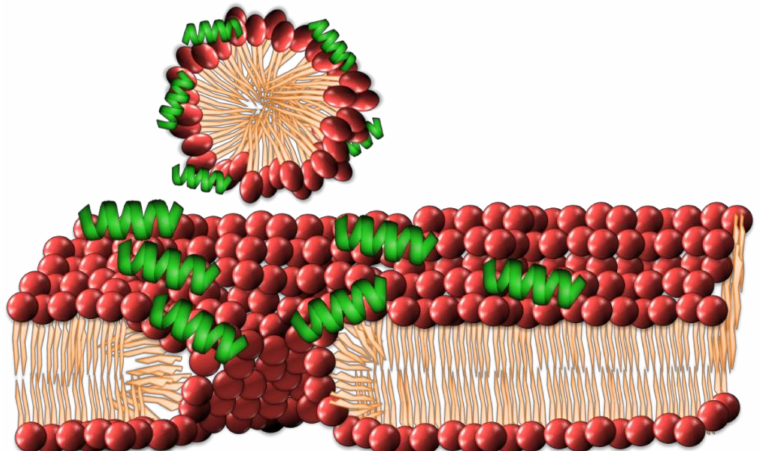
Figure 4. The carpet model of cell membrane disruption has the accumulation of amphipathic AMPs as a ‘carpet’ across the membrane, eventually promoting to the micellization of individual lipids creating membrane